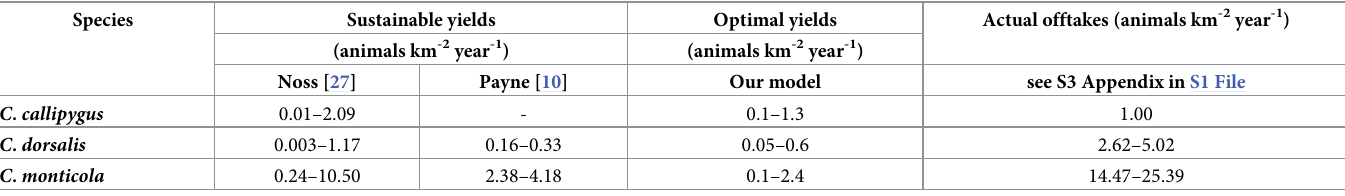
Table 3. Modelled bushmeat yields (animals km-2 year-1) for Peters’ duiker C . callipygus , bay duiker C . dorsalis and blue duiker C . monticola